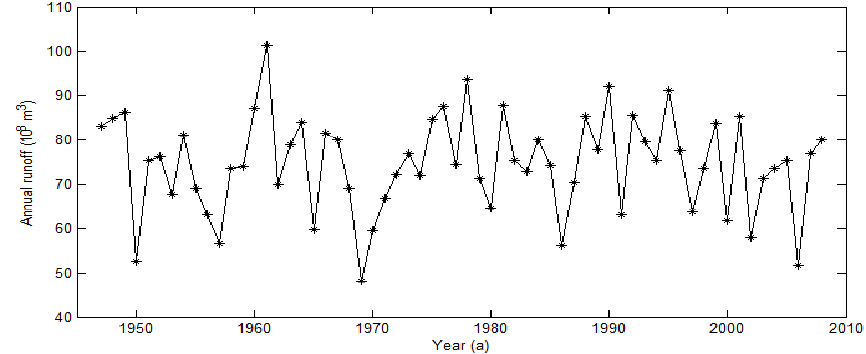
Figure 2. Reconstructed annual sreamflow series.